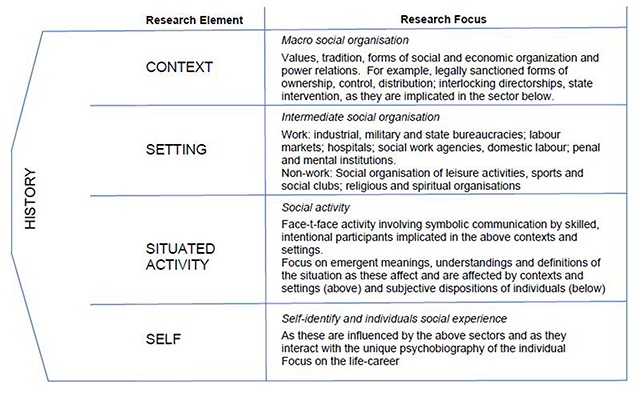
Research Map [11].